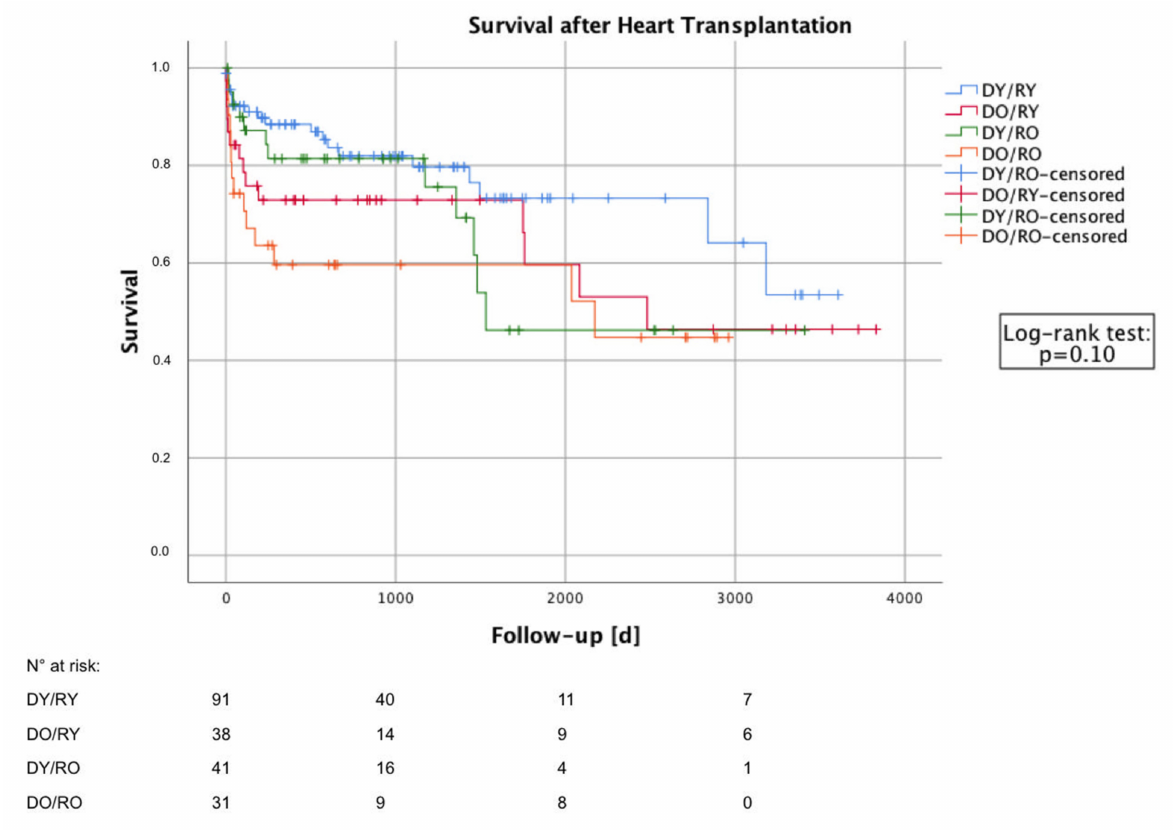
Figure 2. Estimated longer-term survival after heart transplantation by Kaplan–Meier method. Patients were divided into four study groups with regard to the donor and recipient age (donor age ≤ 50 years and recipient age ≤ 60 years: D Y /R Y , n = 91; donor age > 50 years and recipient age ≤ 60 years: D O /R Y , n = 38; donor age ≤ 50 years and recipient age > 60 years: D Y /R O , n = 41; donor age > 50 years and recipient age > 60 years: D O /R O , n =